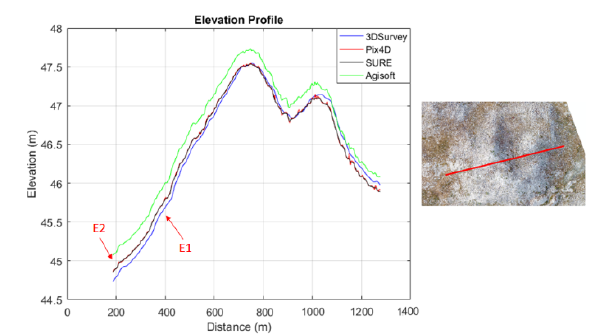
Figure 6. Elevation profiles on DSMs at hills